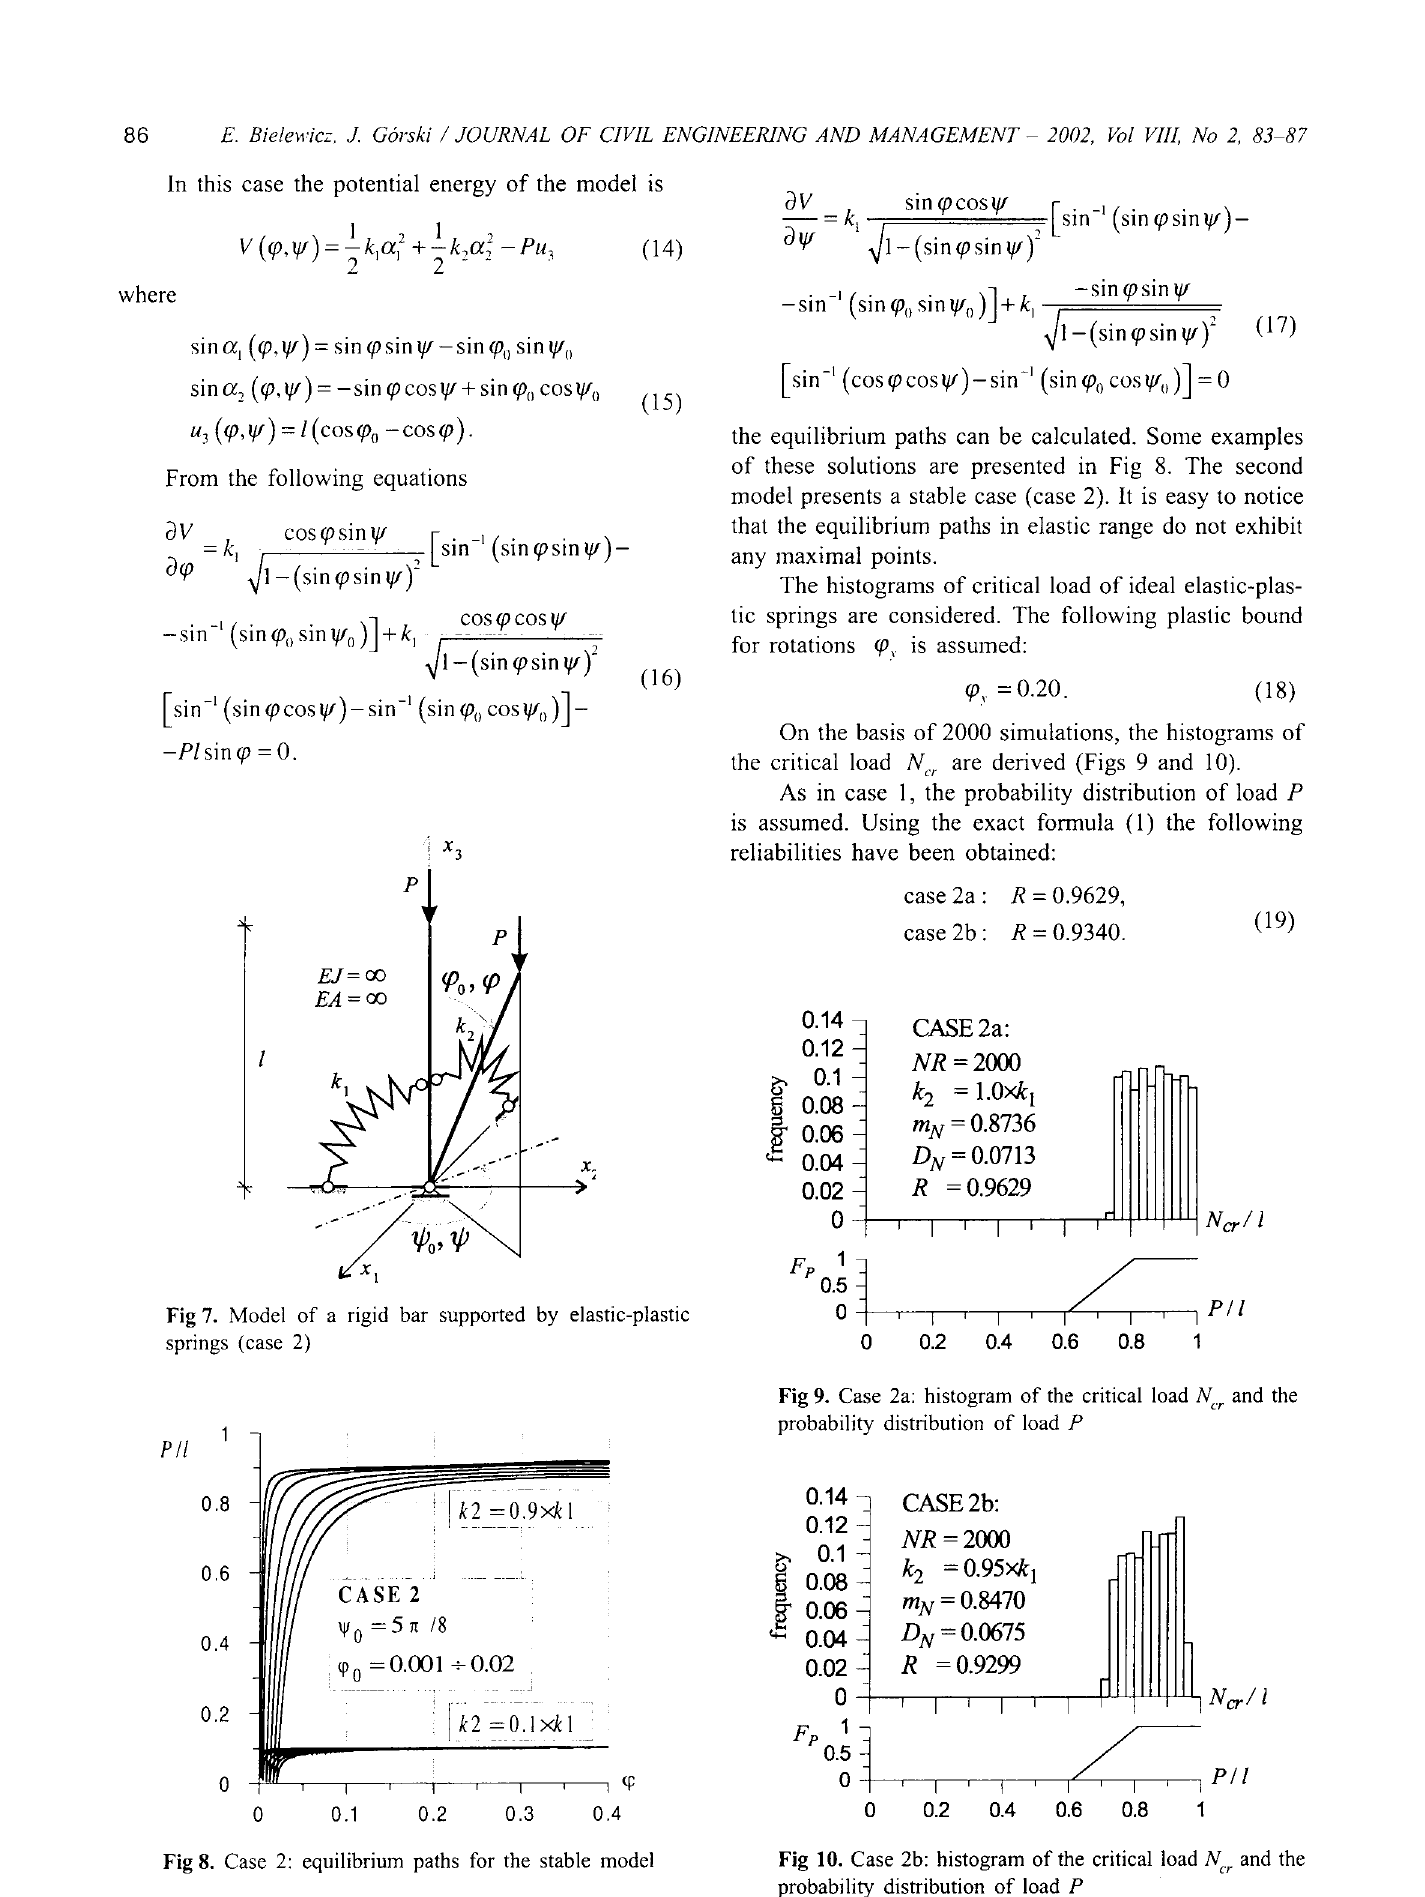
Fig 8. Case 2: equilibrium paths for the stable model